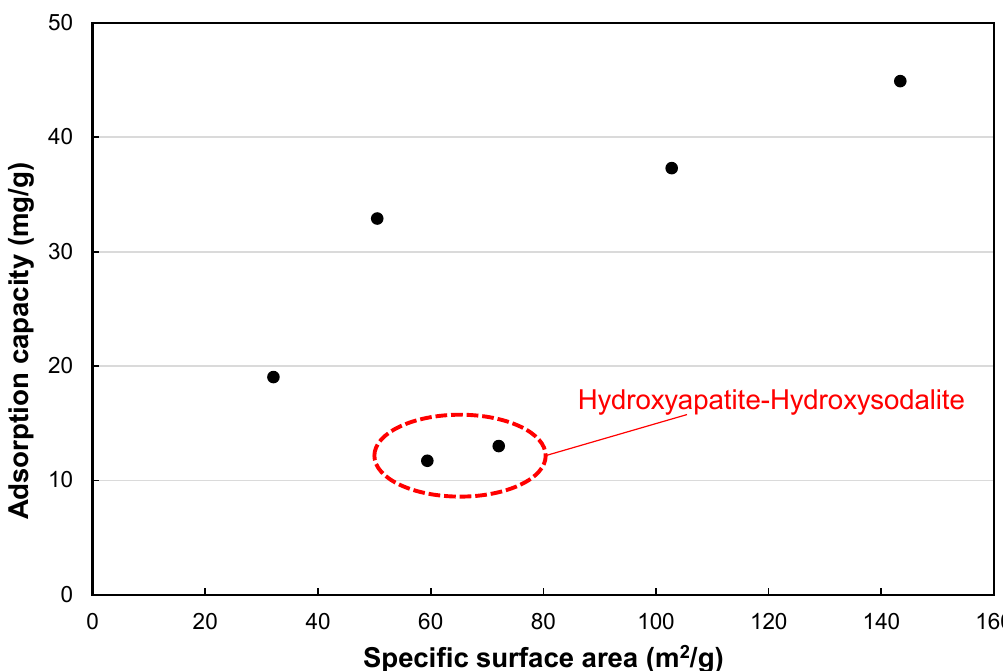
Figure 7. The adsorption capacities of the synthesized composite samples against the BET surface area.